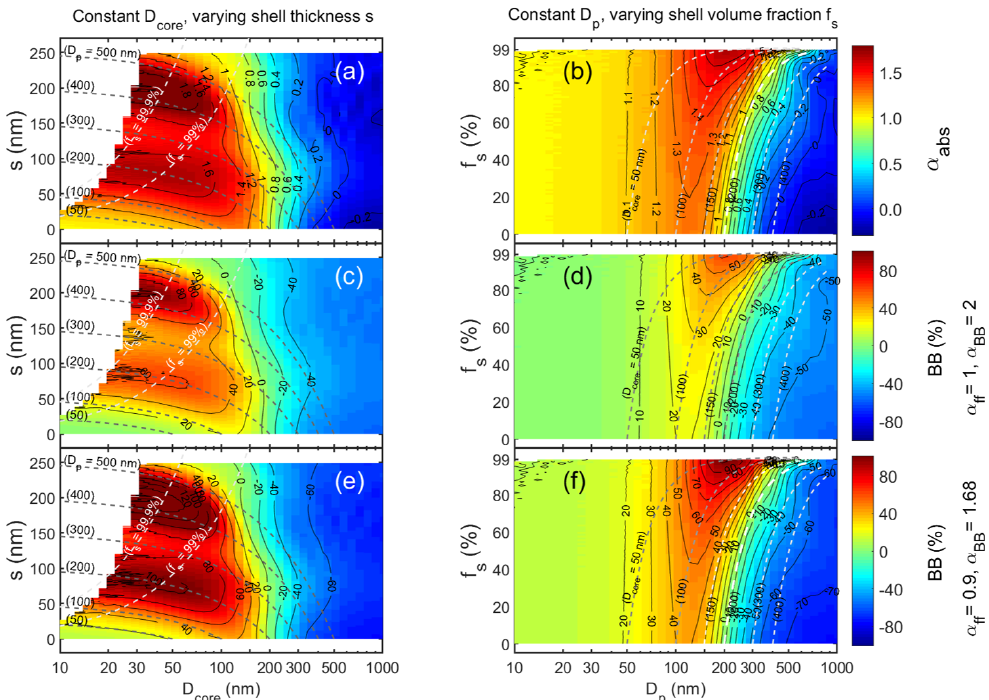
Figure 2. Absorption Ångström exponent ( α abs ) and the fraction of biomass-burning BC calculated from it for single coated particles (a, c, e) as a function of BC core diameter ( D core ) and shell thickness ( s ) and (b, d, f) as a function of particle diameter ( D p = D core + 2 s ) and shell volume fraction f s in the range f s ≤ 99%. In panels (a) , (c) , and (e) , the dark dashed lines show the D core and s of particles that have the same D p – written in parentheses – at all shell thicknesses, and the light dashed lines show the shell thicknesses that correspond to f s = 99% and 99.9%. In panels (b) , (d) , and (f) , the dashed lines show the D p and f s of particles that have the same D core – written in parentheses – at all shell volume fractions. The color bars are common for panels (a) and (b) , (c) and (d) , and (e) and (f) .